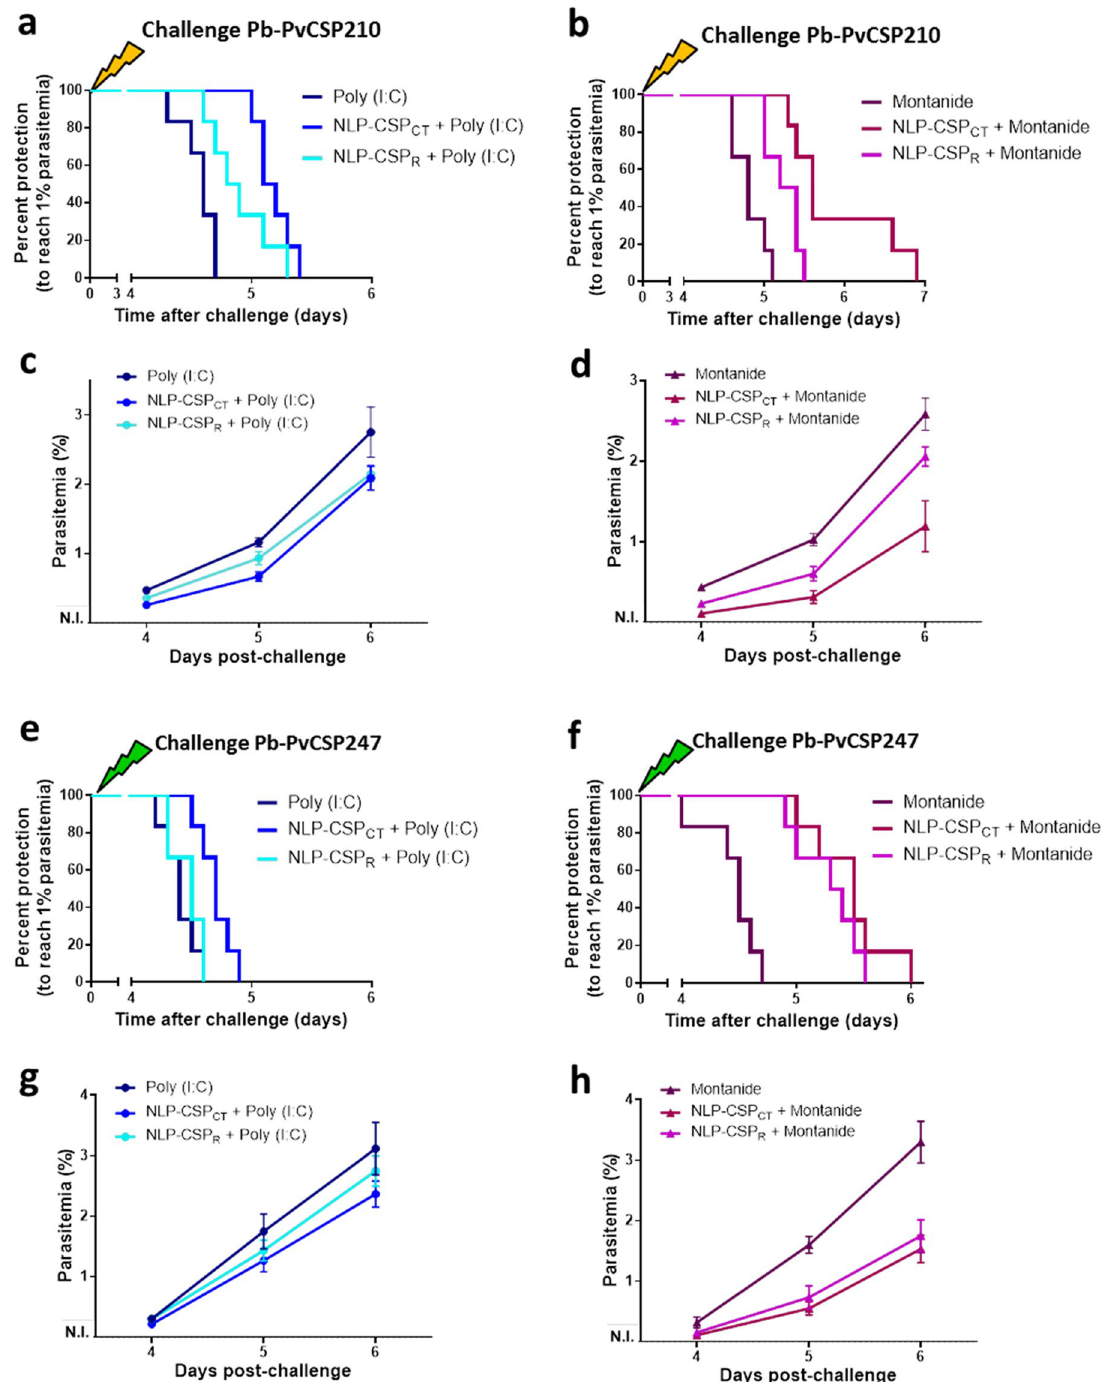
Figure 5. T1% period in immunized mice after challenge with Pb - Pv CSP transgenic sporozoites. Groups of six C57BL/6 mice were s.c. immunized with the vaccine formulations in the presence of Poly (I:C) or Montanide adjuvants, following the scheme shown in Table 1. Upper panel: Immunized mice were challenged 14 days after the third dose with 2,000 Pb - Pv CSPVK210 sporozoites. Percent protection to reach 1% parasitemia ( a , b ) and follow-up analysis of parasitemia at days 4, 5 and 6 after challenge ( c , d ) is shown. Middle panel: Immunized mice were challenged 14 days after the third dose with 2,000 Pb - Pv CSPVK247 sporozoites. Percent protection to reach 1% parasitemia ( e , f ) and follow-up analysis of parasitemia at days 4, 5 and 6 after challenge ( g , h) is shown. Lower panel: Immunized mice were challenged 14 days after the third dose with 2000 spz of the new chimeric Pb-Pv CSP-like G10 parasite. Percent protection to reach 1% parasitemia ( i , j ) and follow-up analysis of parasitemia at days 4, 5 and 6 after challenge ( k , l ) is shown. Significant differences in T1% periods (see Table 2) were analyzed by applying the log-rank (Mantel-Cox)